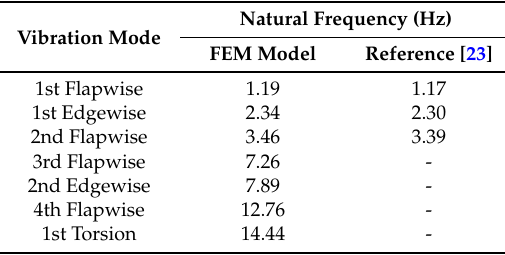
Table 1. Modal frequencies of the stationary